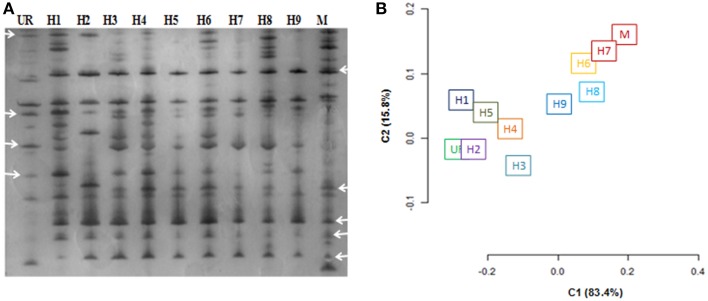
Characterization of regenerated hybrids based on AFLP analysis. (A) AFLP gel wherein arrowheads showed the bands shared by hybrids with either of the fusion partner (B) AFLP based clustering of regenerated hybrids and fusion partners. % represents the explained variance at PC1 and PC2. UR, U. reticulata; M, M. oxyspermum; H1–9, Hybrids.